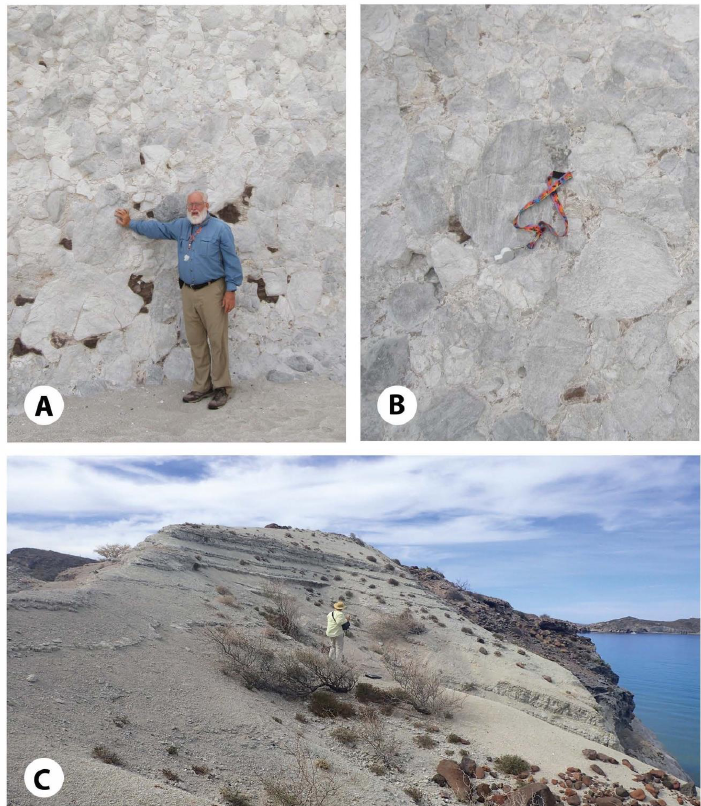
Figure 3. Effusive volcanics from rhyolite domes near Rancho Santa Ana: ( A ) Re-sedimented hyaloclastite deposit with dark chert inclusions, ( B ) Closer view of fitted blocks (hand lens and band for scale), ( C ) Thin-bedded hydromagmatic tuffs above a banded rhyolite flow (person for scale).